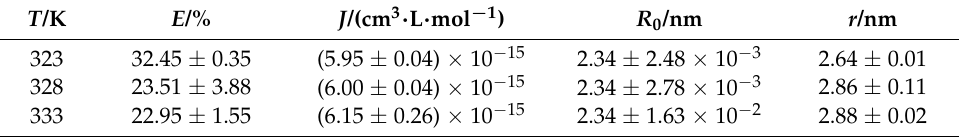
Figure 8. Overlap of fluorescence emission spectrum of lysozyme (1) with the absorption spectrum of tannic acid (2) at T = 333 K. Table 4. Parameters of E , J , R 0 , r of the lysozyme–tannic acid system at 323, 328 and 333 K .